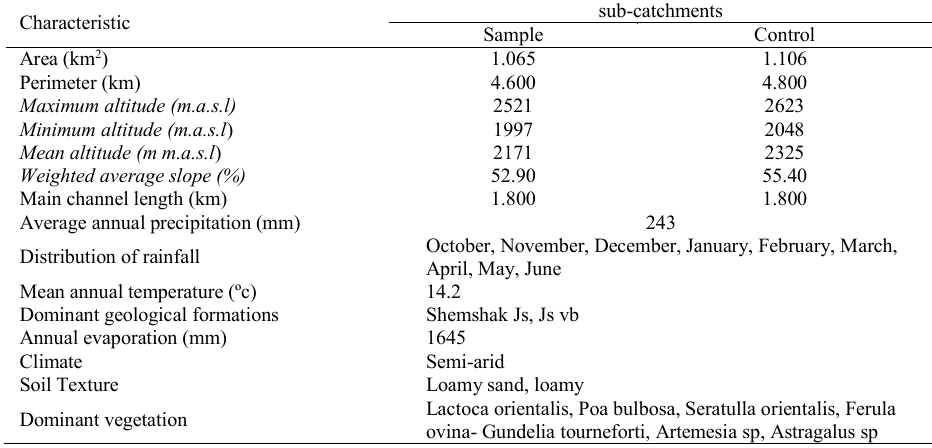
Table 1: Physical characteristic of the control and sample sub-catchments (Eshghizadeh et al .,